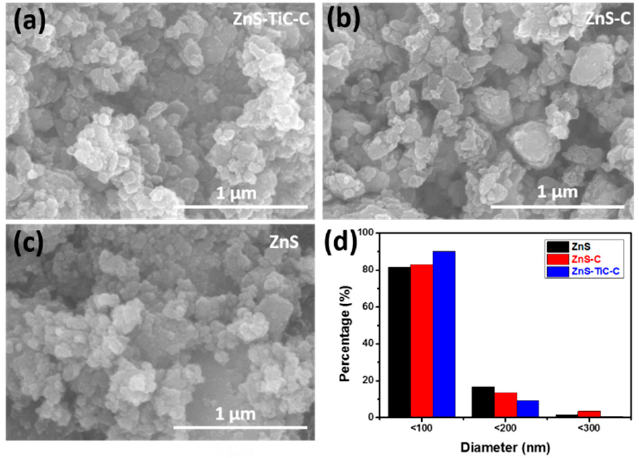
Figure 2. SEM images of the ( a ) ZnS-TiC-C, ( b ) ZnS-C, ( c ) ZnS composites; and ( d ) particle-size distributions of the ZnS, ZnS-C, and ZnS-TiC-C composites.